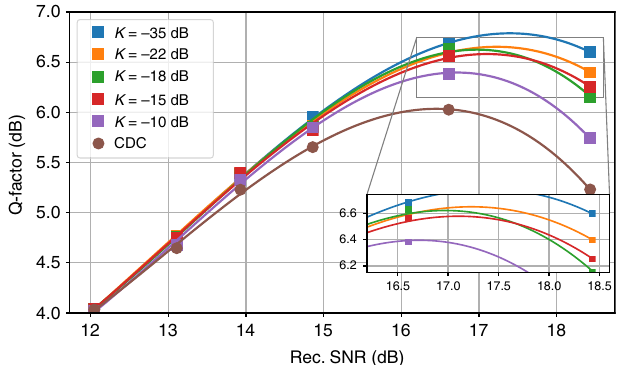
Fig. 7 Trimming threshold. The impact of trimming threshold κ on the NN- NLC with Leaky ReLU at the receiver side after 2800 km transmission